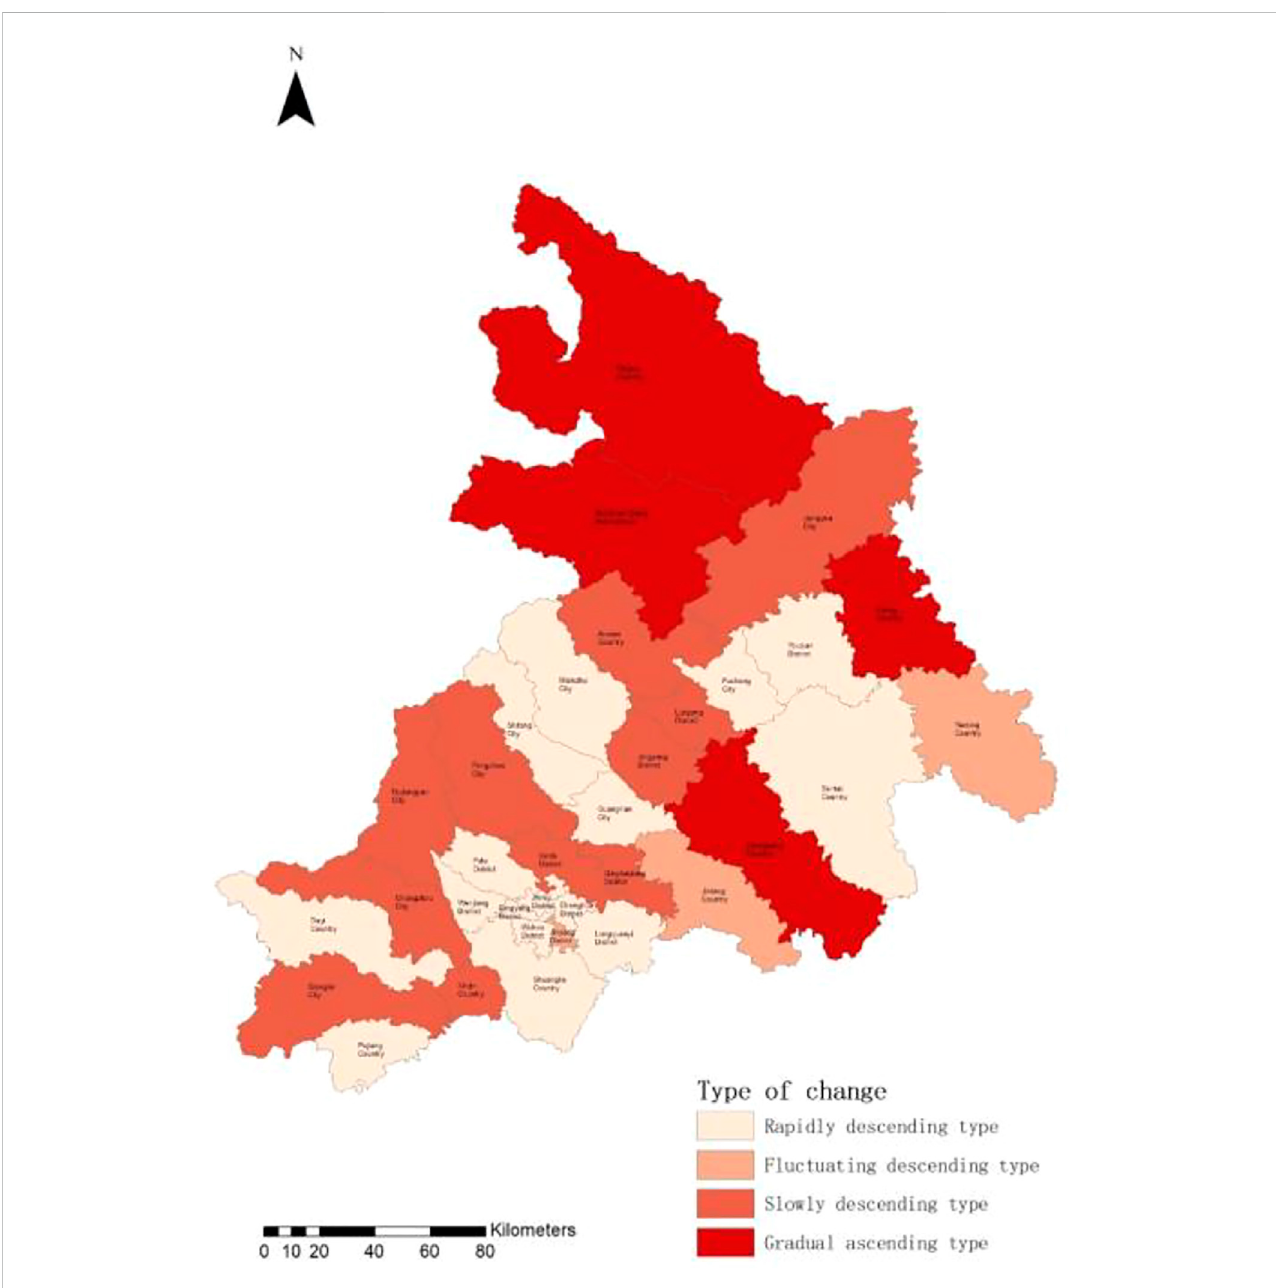
FIGURE 5 Types of the spatial evolution of urban resilience